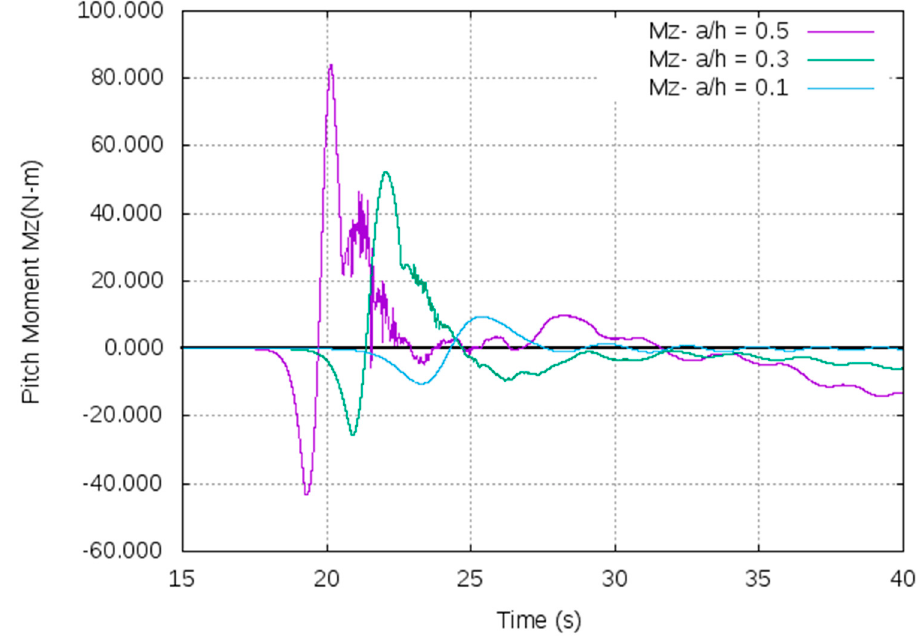
Figure 11. Pitch moment experienced by the pontoon while encountering solitary waves (for 0.1, 0.3, and 0.5 a h = ).